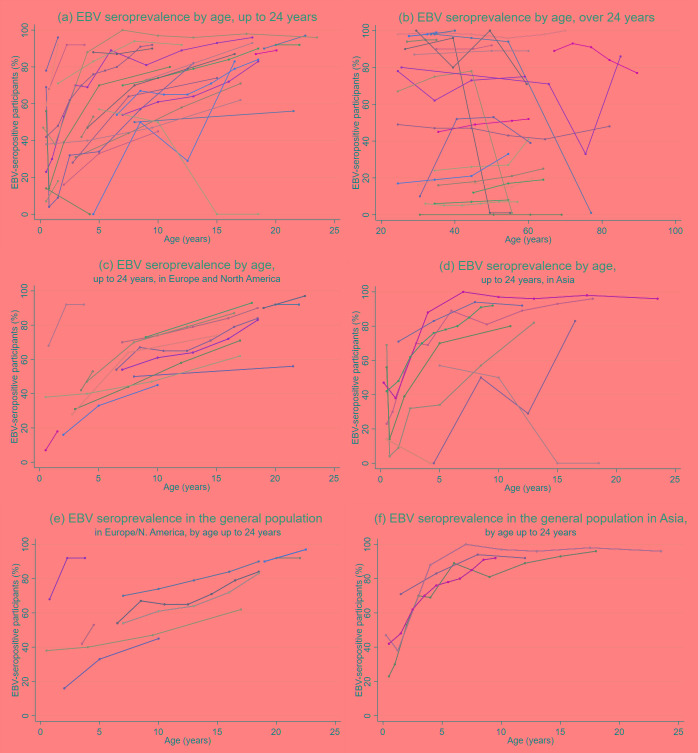
EBV seroprevalence by age in studies identified from the literature. Panel A. In participants up to 24 years of age. Panel B. In participants over 24 years of age. Panel C. In participants up to 24 years of age in Europe and North America. Panel D. In participants up to 24 years of age in Asia. Panel E. In participants up to 24 years of age in studies representative of their underlying populations in Europe and North America, (f) in participants up to 24 years of age in studies representative of their underlying populations in Europe and North America. Seroprevalence data categorised by age group was extracted from the literature and data points were plotted at the mid-point of each age group. Studies with only one data point above or below 24 years were excluded from the relevant graph. Studies were considered generalisable to the underlying population if it was a random sample of healthy individuals and the study population was representative of the local population.